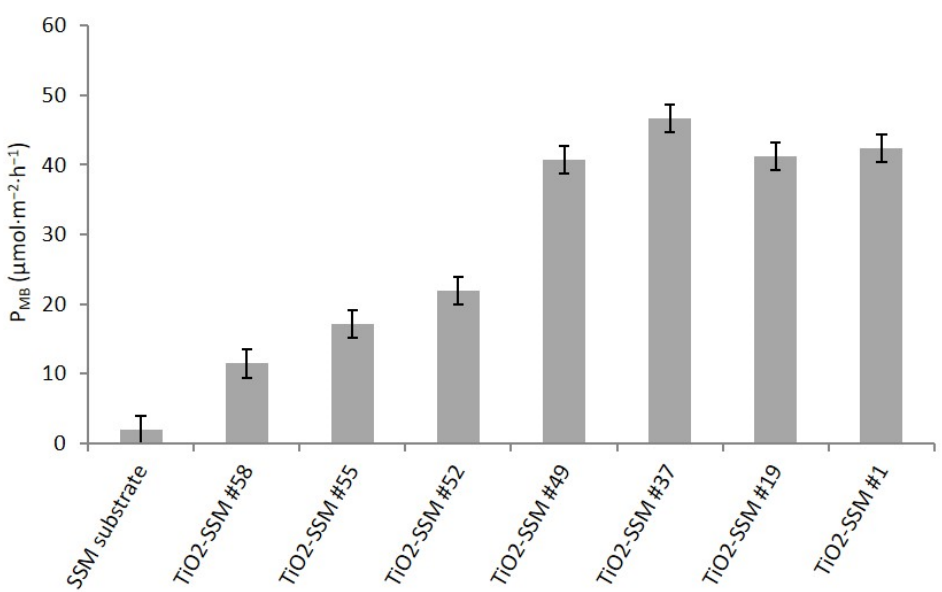
Figure 7. Photocatalytic activity by ISO 10678:2010 for the investigated samples as a function of the position in the large TiO 2 -SSM substrate.